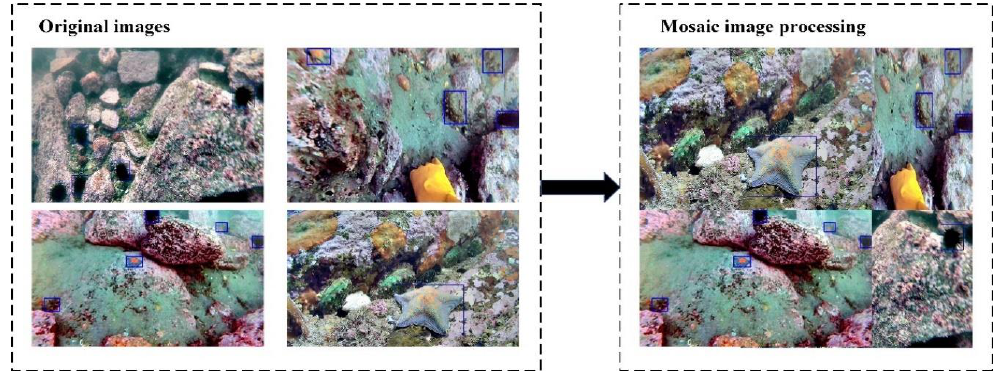
Figure 7. Schematic diagram of the Mosaic algorithm.